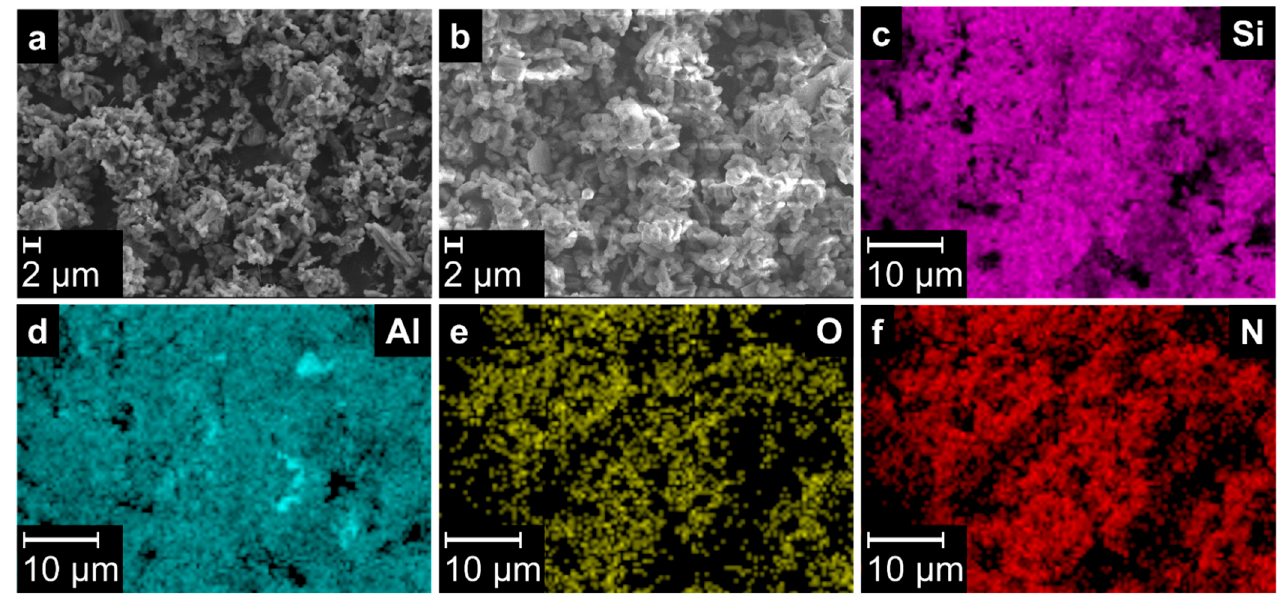
Figure 2. SEM-images of the samples SiAlON-1 ( a ) and SiAlON-2 ( b ) and element mapping with EDX spectroscopy for the sample SiAlON-1 ( c – f ).